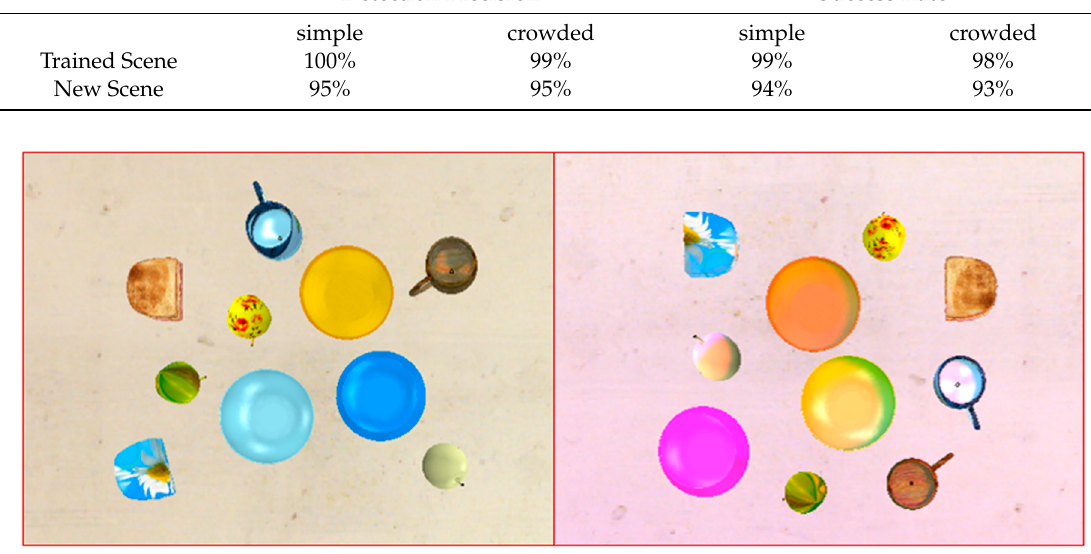
Figure 10. Different scenes with multiple objects placed on the table.